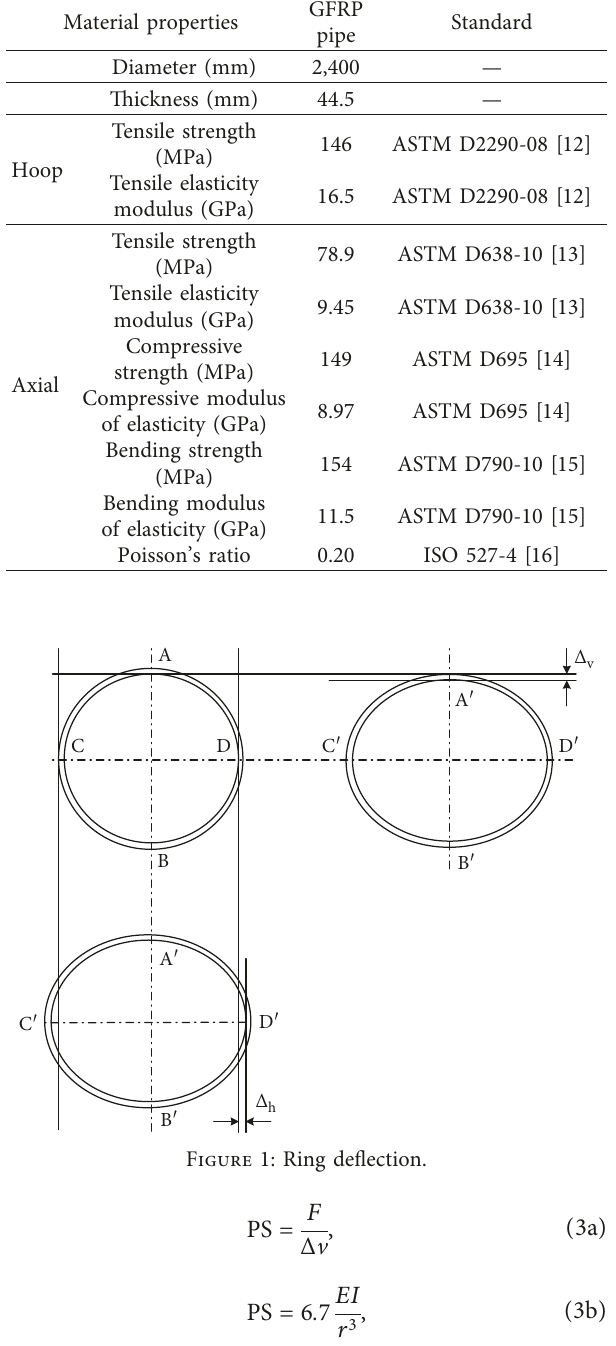
Table 1: Mechanical properties of the GFRP pipe. Material properties